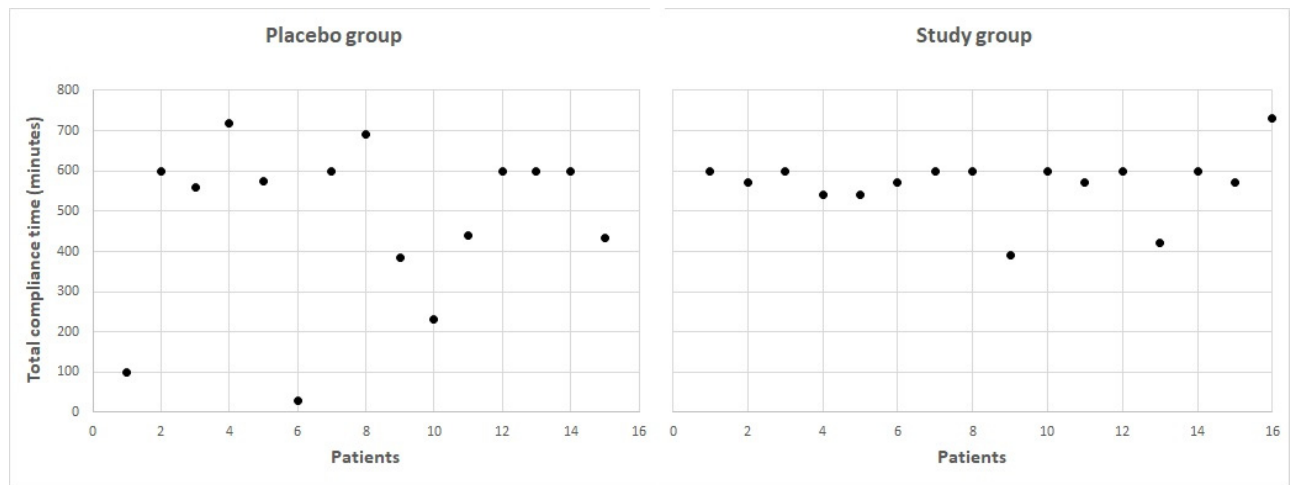
Figure 2. Total compliance time for all the patients included in the two evaluated sample groups.